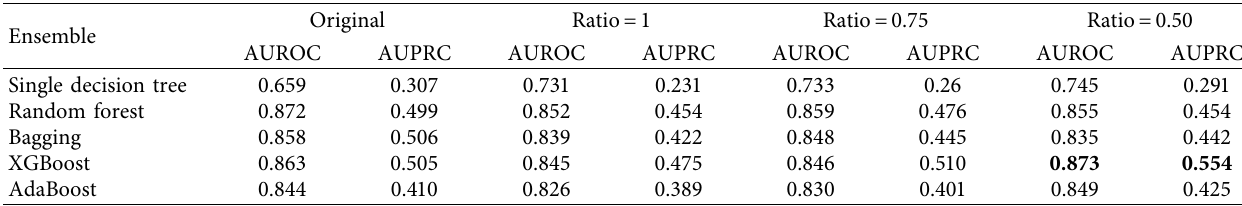
Table 4: The performance of Standard decision tree ensembles with RUS undersampling method for different ratios of minority and majority class points. AUROC and AUPRC performance measures are used in the